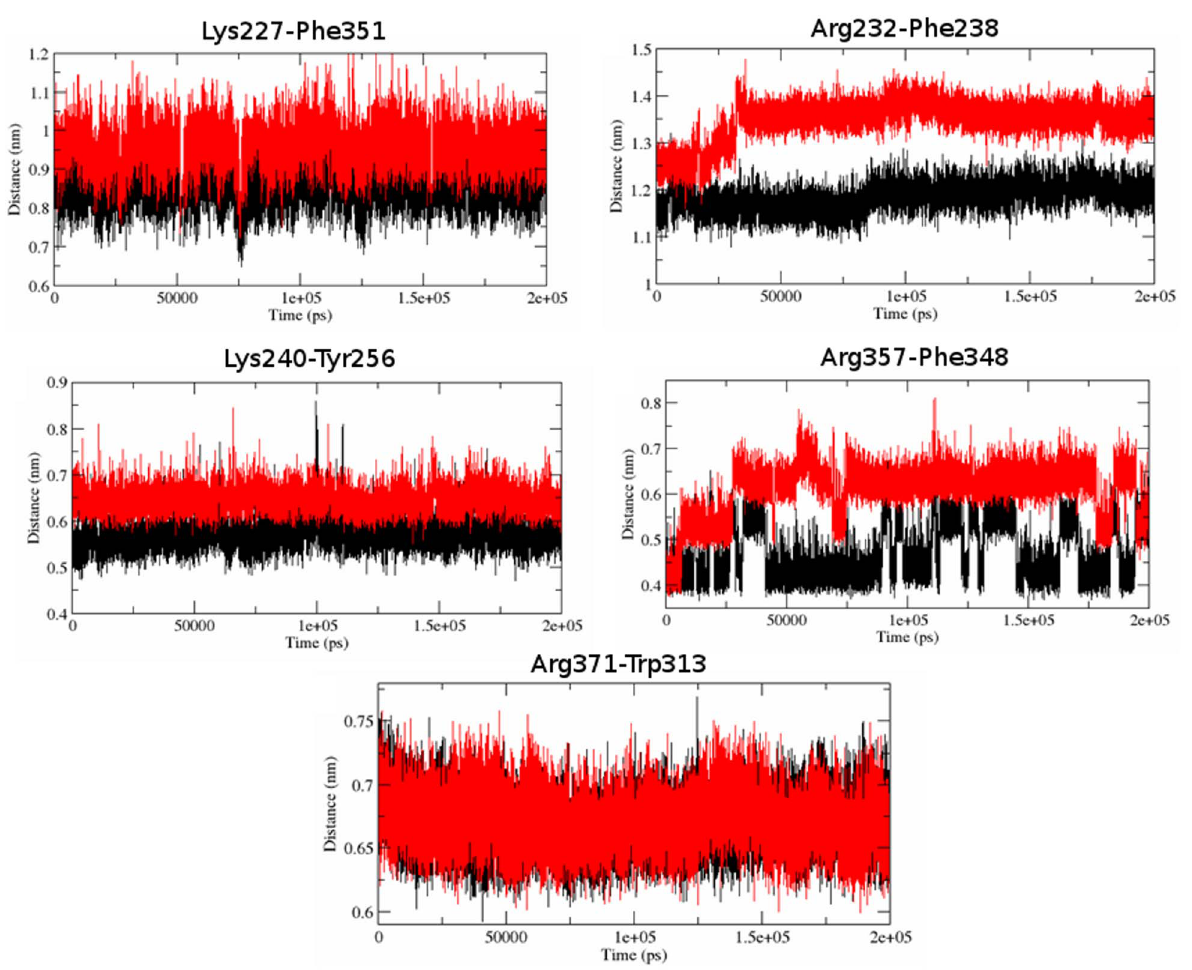
Figure 14. Distance fluctuation between the cation- p residues a) Lys227-Phe351 b) Arg232-Phe238 c) Lys240-Tyr256 d) Arg357- Phe348 e) Arg371-Trp313. Native is shown in black and mutant in red.